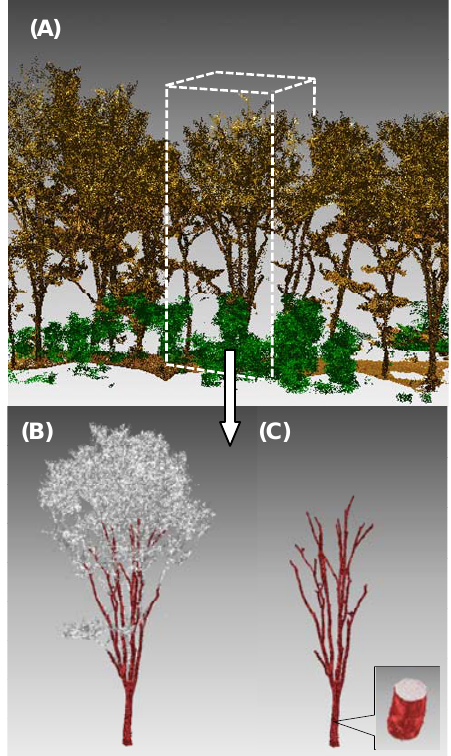
Figure 6: The 3-D voxel-based solid model of the zelkova tree generated from the 3-D point cloud data obtained by portable scanning lidar. (A) A point cloud image of a group of zelkova trees before voxelization. Area enclosed by dashed lines is the target tree within the measurement plot. (B) The 3-D model of the target tree: small branches are white. (C) Stem and large branches only. In the cross-section of a part of the stem, the interior voxels are colored white (modified from Hosoi et al.,